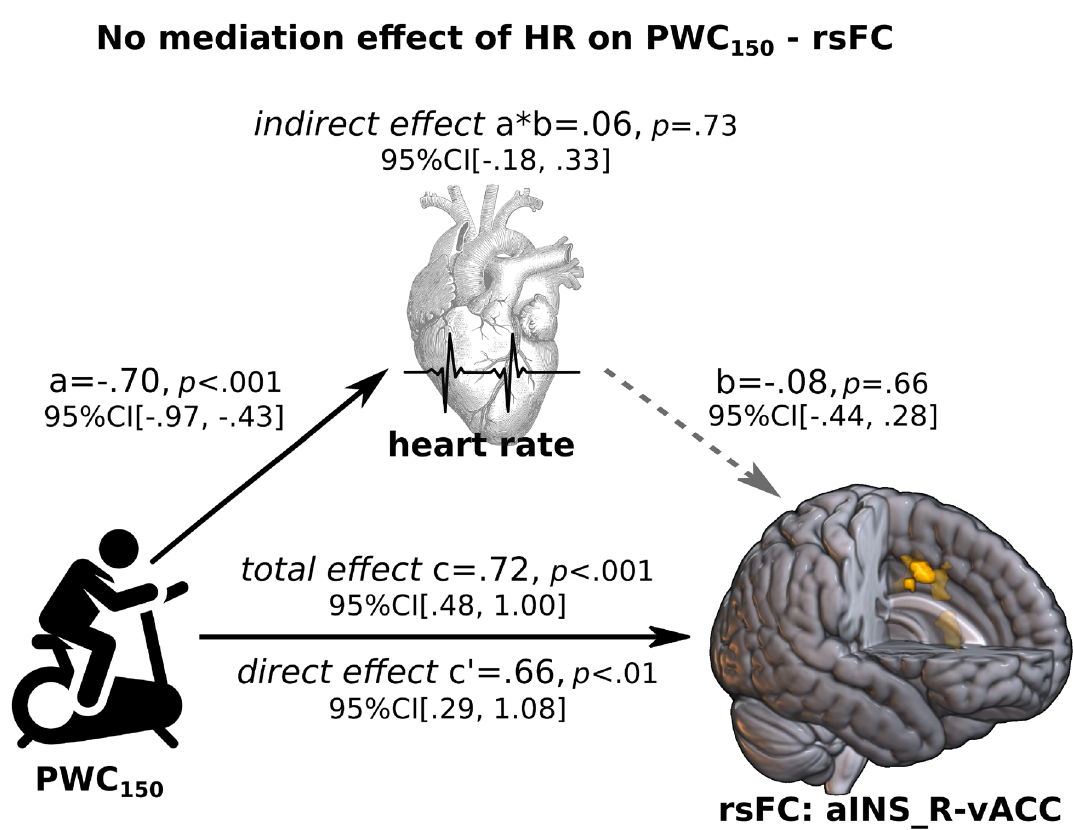
Figure 3. Representative mediation analysis for a given cluster of seed-based rsFC differences (aINS_R-vACC) between athletes and non-athletes adjusted by age and BMI. Alterations in rsFC are due to regular physical exercises and are not mediated by heart rate. Path “a” is the effect of PWC 150 (causal variable) on heart rate (mediator). Path “b” is the effect of heart rate (mediator) on aINS_R-vACC connectivity (outcome variable), partialling out the effect of PWC 150 . The indirect effect a*b measures the amount of mediation, and the direct effect c’ is the effect of PWC 150 on rsFC after controlling for heart rate. The total effect is the sum of direct and indirect effects. All path estimates are depicted as standardized regression coefficients with their respective p-value and 95% confidence interval (CI). The dashed gray line indicates the non-significant result obtained for path “b.” Icons for bike, heart and heart rate signal were obtained from frees vg. org. aINS_R - right anterior insula, vACC—ventral anterior cingulate cortex, rsFC—resting-state functional connectivity, PWC 150